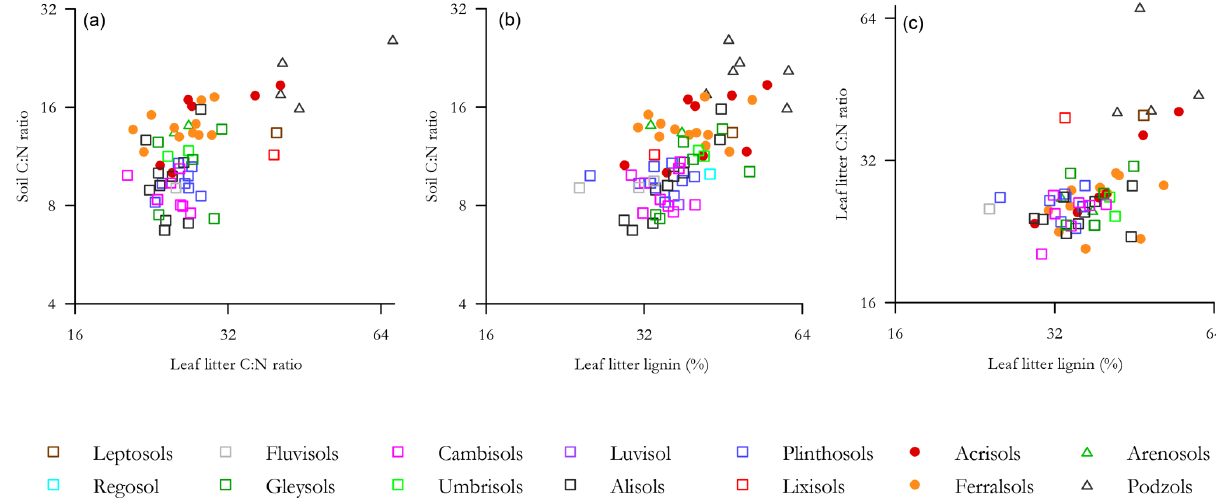
Figure 9. The relationship of leaf litter lignin content with both leaf litter and soil C:N ratios. (a) Soil C:N ration as a function of leaf litter C:N ratio, (b) soil C:N ratio as a function of leaf litter lignin concentration and (c) leaf litter C:N ratio as a function of leaf litter lignin.